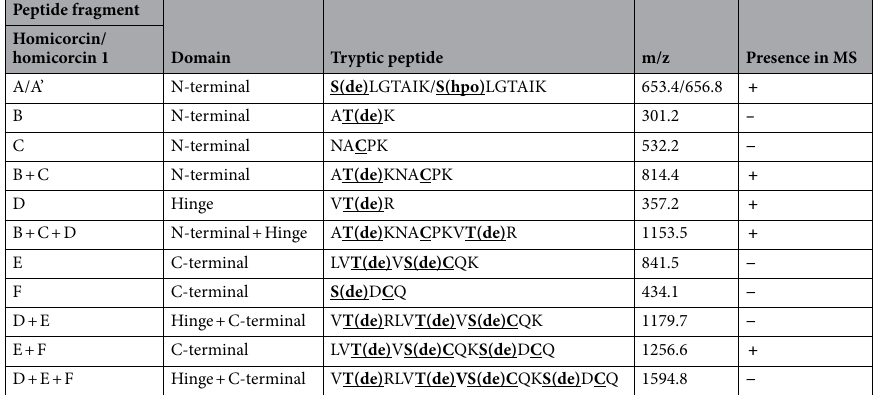
Table 2. Possible tryptic peptides of homicorcin and its variant and their presence in MS analysis. A’ denotes fragment A of homicorcin 1 where dehydrated first Ser residue was modified to 2-hydroxypropionate (Hpo). Domain name represents the fragment position in the core peptide. Bold and underlined ‘S(de)’ or ‘T(de)’ residues are predicted to be dehydrated and ‘C’ are predicted to form thio-ether linkage with dehydrated S/T residues. . ( +) and (−) represents the presence or absence respectively of the fragment in MS analysis.